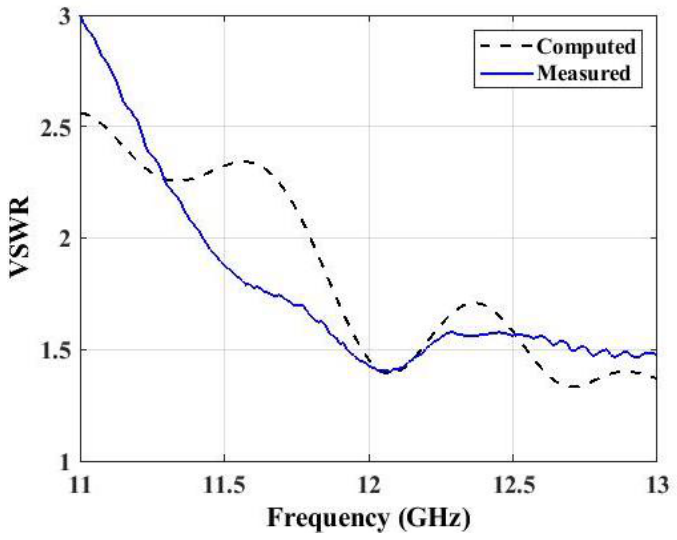
Figure 8. Computed and measured Voltage Standing Wave Ratio (VSWR) of the RCA with the